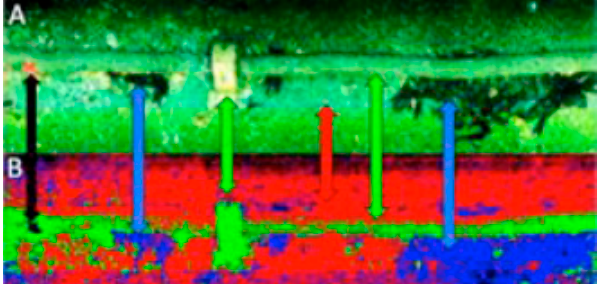
Figure 7. Underwater pipeline inspection: ( A ) False RGB image of a pipeline and surrounding objects, and ( B ) unsupervised classification image based on the data in ( A ). Reprinted from Johnsen et al. [92]. Acknowledgement of © 2016 International Federation of Automatic Control.